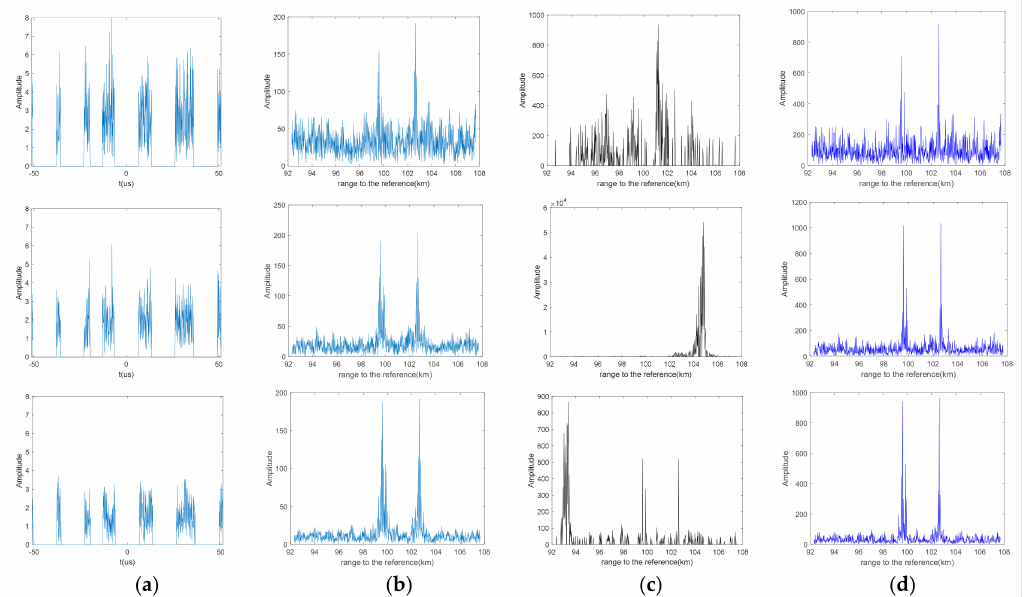
Figure 4. The waveform of the jamming rejected signal ( a ) and the reconstruction results of tradition FFT ( b ), sparsity adaptive matching pursuit algorithm (SAMP) ( c ), Bayesian compress sensing (BCS) ( d ), separately on η = 31.3% with di ff erent signal-to-noise ratio (SNR). (From top to bottom, the signal-to-noise ratio of the echo signals are SNR = − 5 dB, SNR = 0 dB, SNR = 10 dB, respectively).